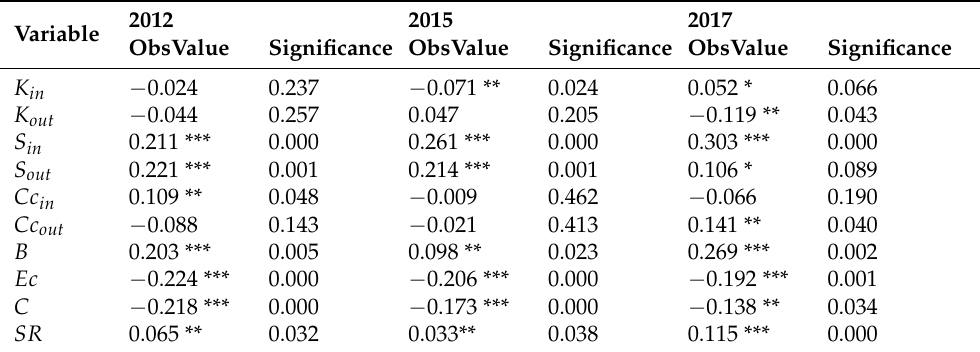
Table 5. QAP correlation analysis results of